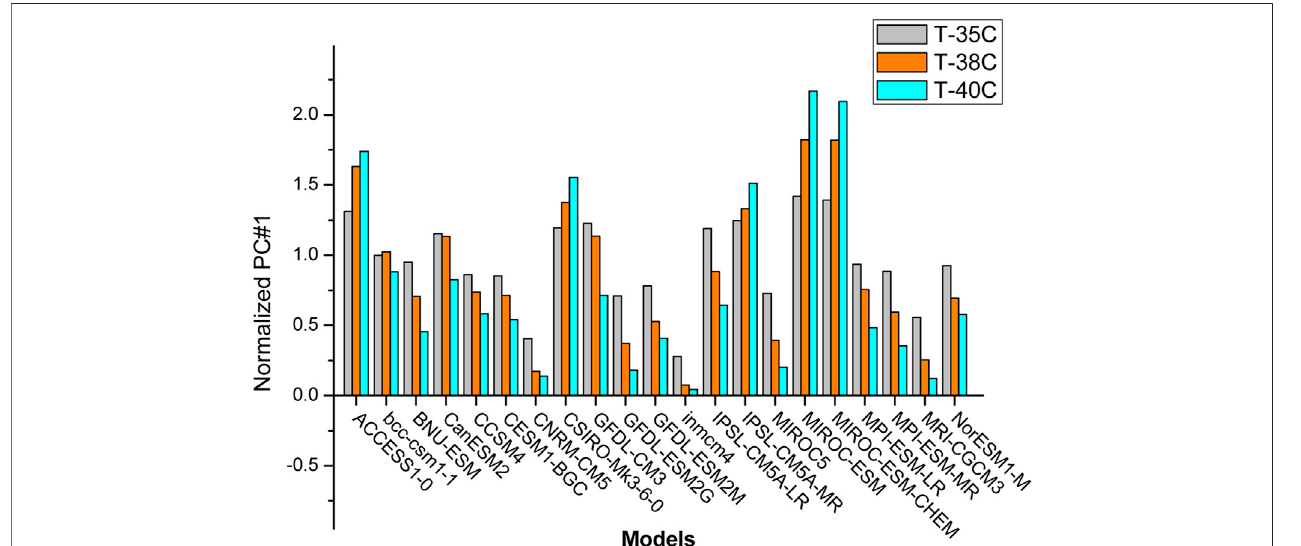
FIGURE 4 | The PCs of the fi rst EOF mode at three different T-levels corresponding to Figure 3 .